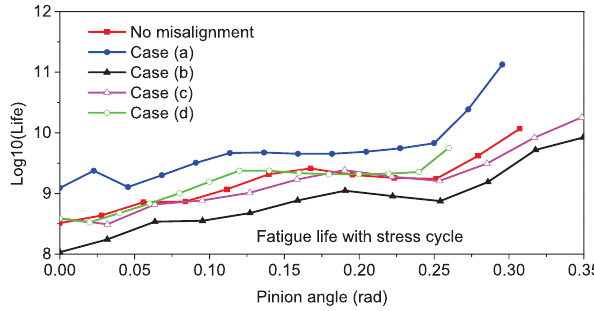
Fig. 17 Fatigue life under different cases of assembling misalign- ments (with the asperity stress cycle counting).